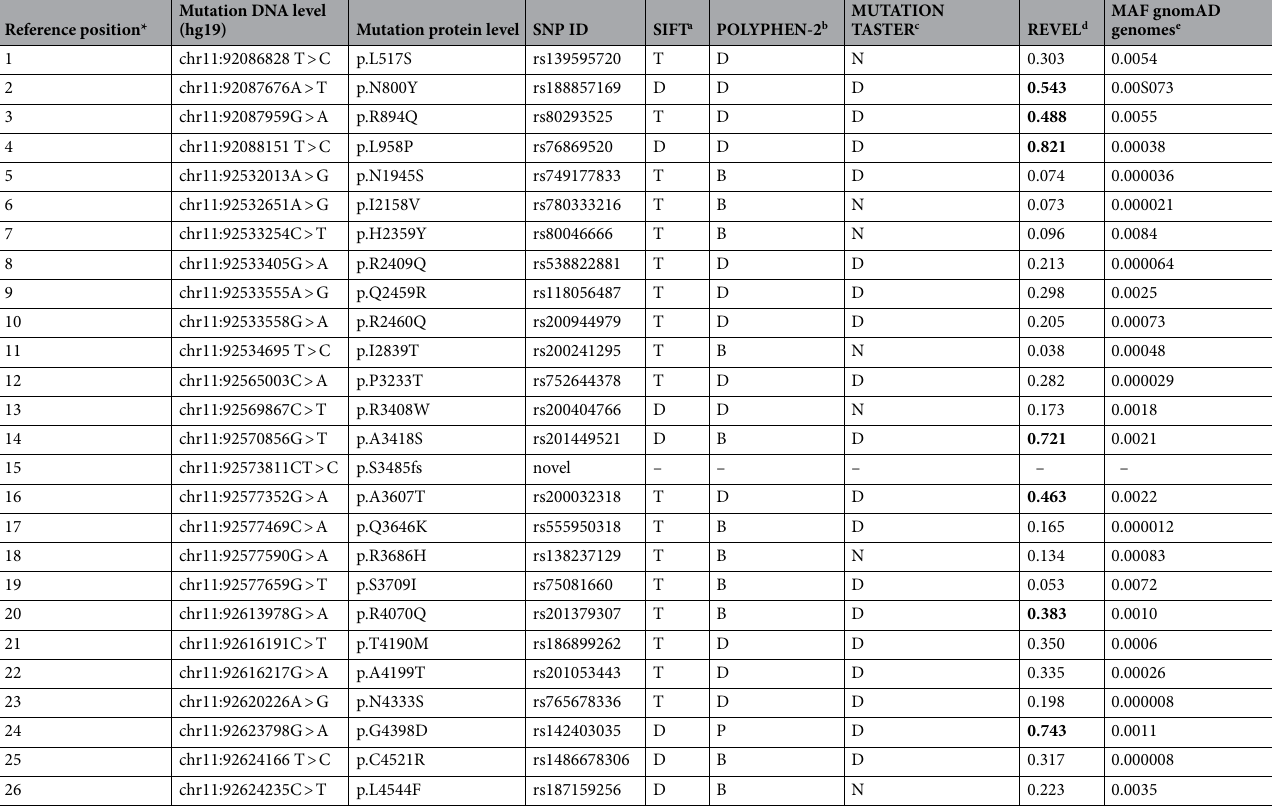
Table 6. Prediction of FAT3 variant effects on the function of the protein. a SIFT: D, damaging, T, tolerated. b POLYPHEN-2: D, probably damaging, P, possibly damaging, B, benign. c MUTATION TASTER: D, disease causing, N, polymorphism. d REVEL: score from 0–1, less to more pathogenic, sensitivity equal to specificity at 0.380. e In a few cases MAF is from gnomAD Exomes, normally essentially identical to genomes. * Position of each variant of FAT3 protein is illustrated in Fig. 1a. Significant values are in